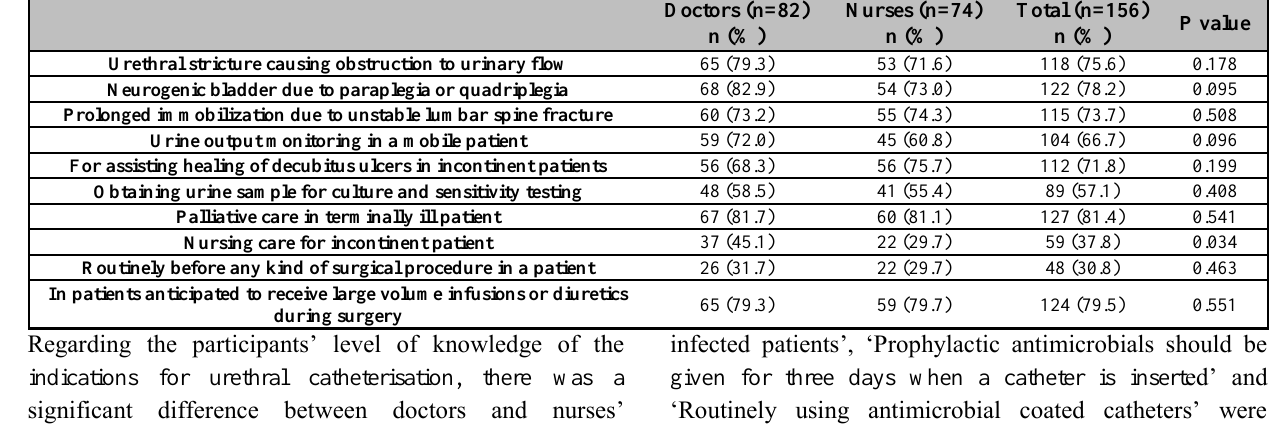
Table 3: Number of doctors and nurses correctly identifying methods to prevent CAUTI Doctors